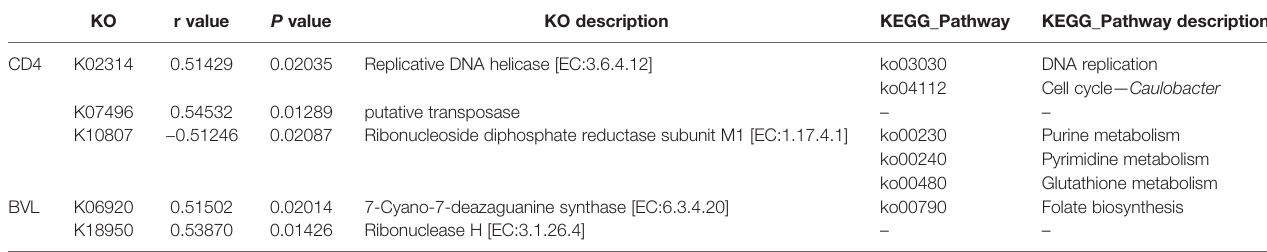
KO, KEGG Orthology; EC, Enzyme naming and numbering of Enzyme Commission of IUB; ko, pathway of